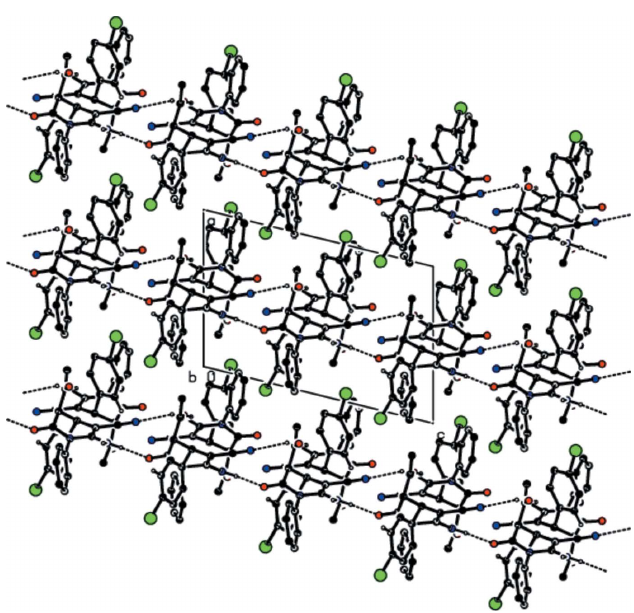
Figure 4 The crystal packing of the title compound viewed down the b axis, showing chains running along the c axis formed through N—H (cid:2)(cid:2)(cid:2) O and N—H (cid:2)(cid:2)(cid:2) N hydrogen bonds.